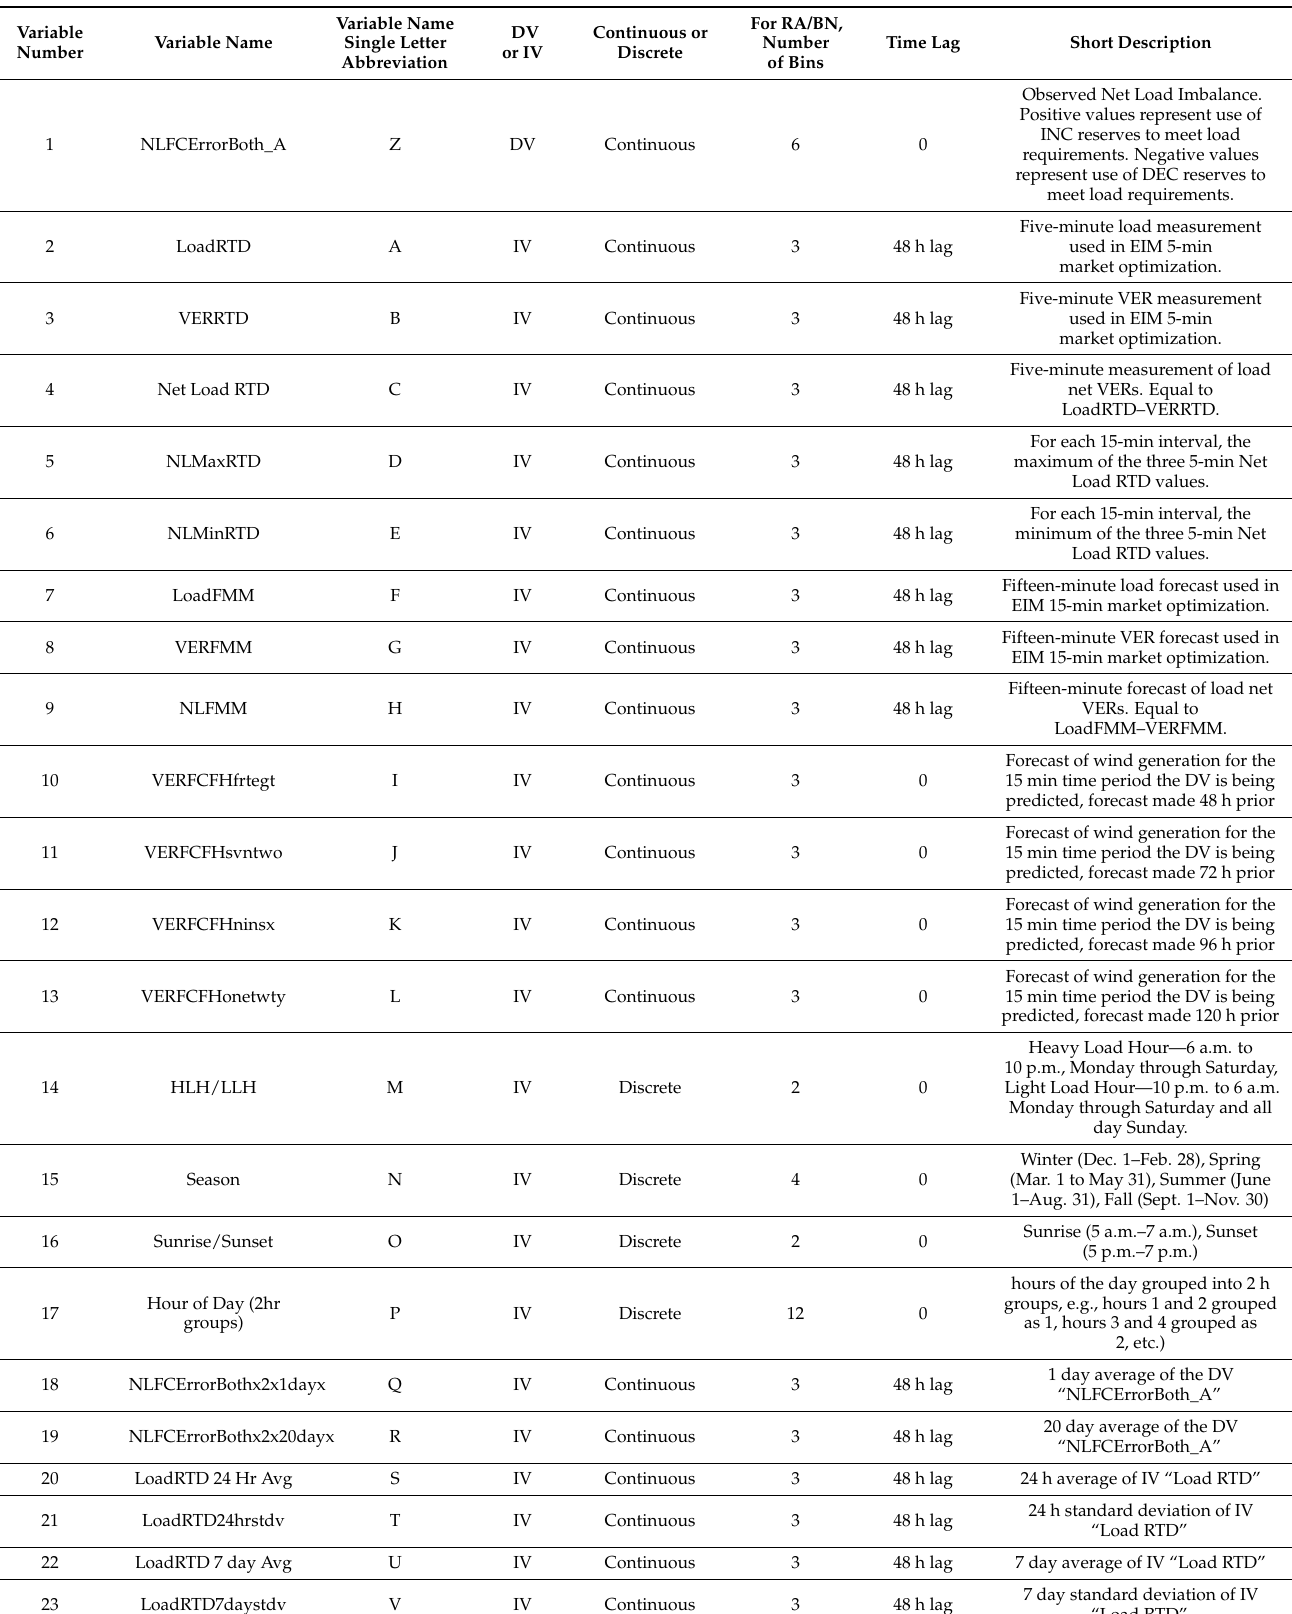
Table 1. Variable Names and